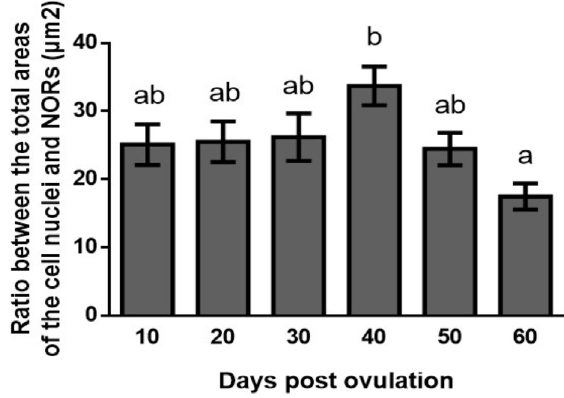
Figure 3 - Mean and standard error of the number of nucleolar organizer regions (NORs), the largest numbers of NORs are indicative of greater cell proliferation of the endometrium of the horns of the bitches at 10 (n=10), 20 (n=7), 30 (n=8), 40 (n=8), 50 (n=6) and 60 (n=9) days post ovulation. Different letters indicate statistically significant differences (p <0.05).